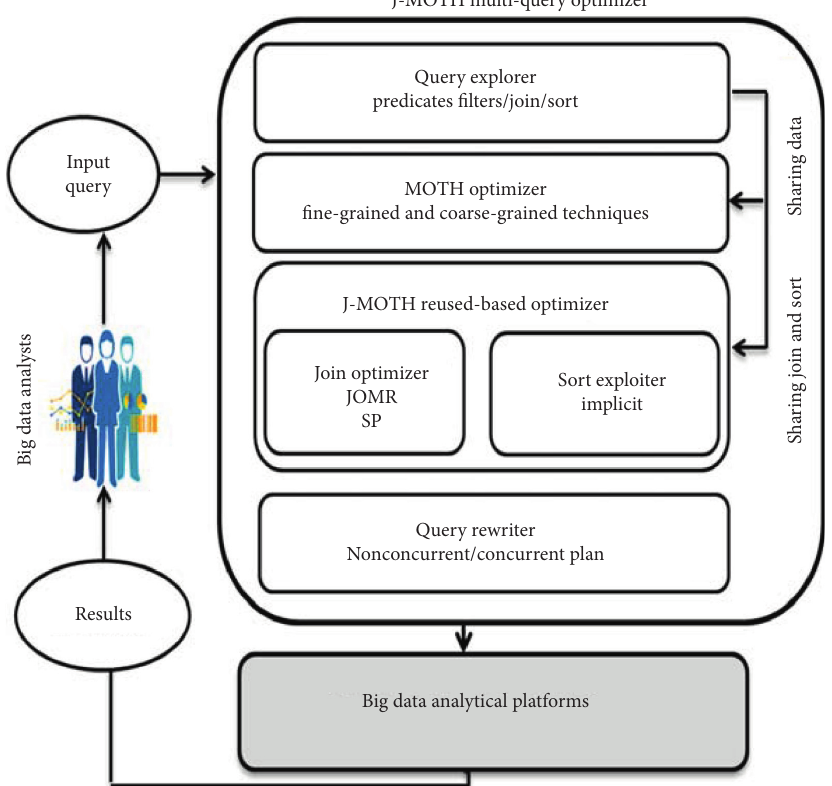
Figure 2: The J-MOTH system architecture.